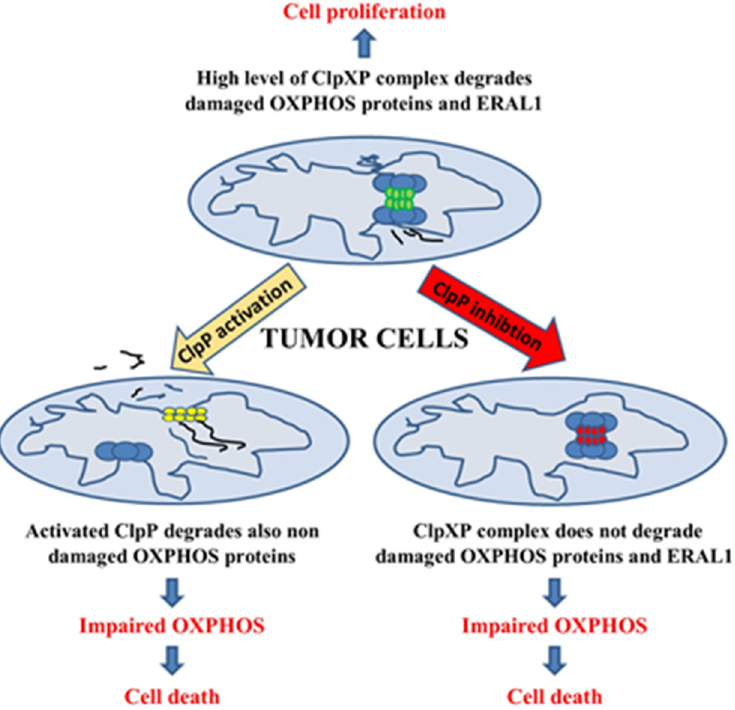
Figure 1. Effects of chemical modulation of ClpP on tumor cells relying on OXPHOS. High levels of ClpPX complex allow the removal of damaged OXPHOS proteins and ERAL1. This ensures the integrity of the respiratory chain and mitochondrial ribosome assembly, thus maintaining mitochon- drial functionality and promoting tumor cell proliferation. ClpP activation causes the degradation of non-damaged OXPHOS proteins leading to impaired OXPHOS, mitochondrial dysfunction, and ultimately cell death; ClpP inhibition does not allow the removal of damaged OXPHOS proteins and ERAL1 leading to impaired OXPHOS, altered ribosome assembly, mitochondrial dysfunction, and ultimately cell death.